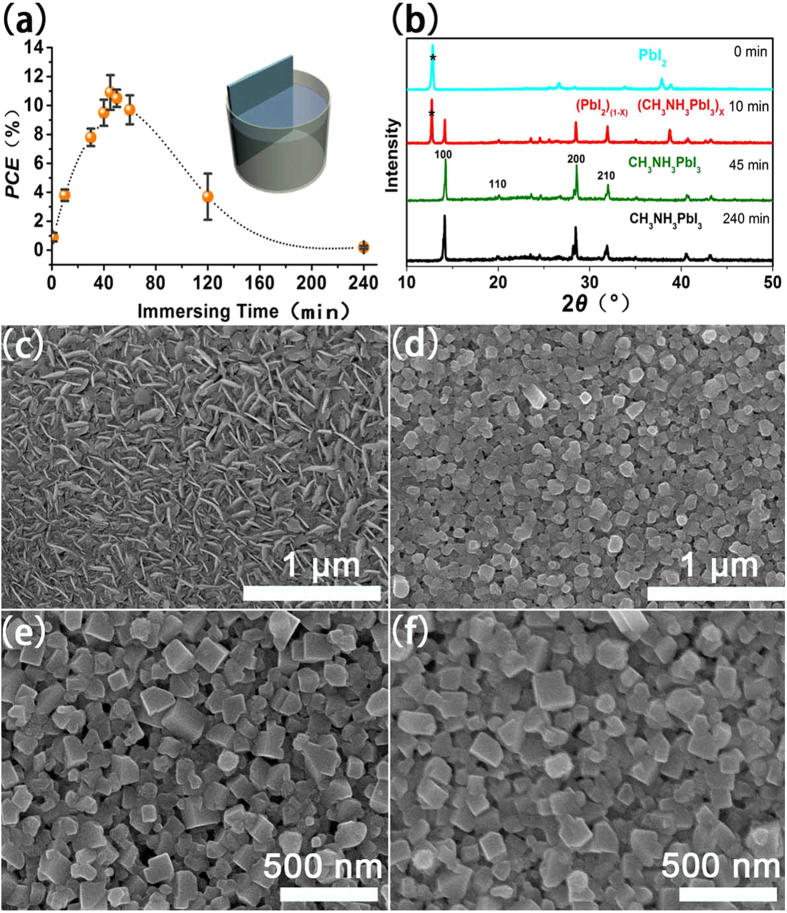
(a) The PCE of the devices as a function of immersing time. 12 solar cells were repeated and measured for each immersing time; (b) XRD patterns of PbI2 film with different immersing time in MAI solution; (c) SEM image of the PbI2 film deposited by thermal evaporation on Glass/FTO/cp-TiO2 substrate without immersing in MAI; (d) SEM image of the product obtained by immersing PbI2 film in CH3NH3I for 10 min; (e) SEM image of MAPbI3 layer prepared by immersing PbI2 film in MAI for 45 min; (f) SEM image of MAPbI3 layer fabricated with immersing PbI2 film in MAI for 240 min.